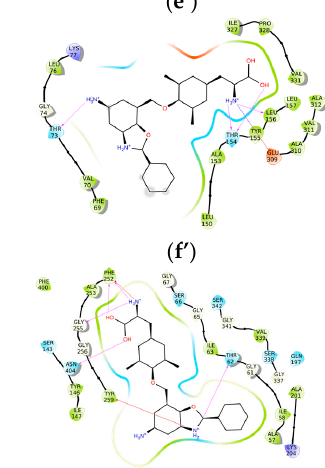
Table 1. Docking G.S. (kcal/mol) for the 20 amino acids in the four LAT1 conformations. Outward Amino Acid Open His − 5.72